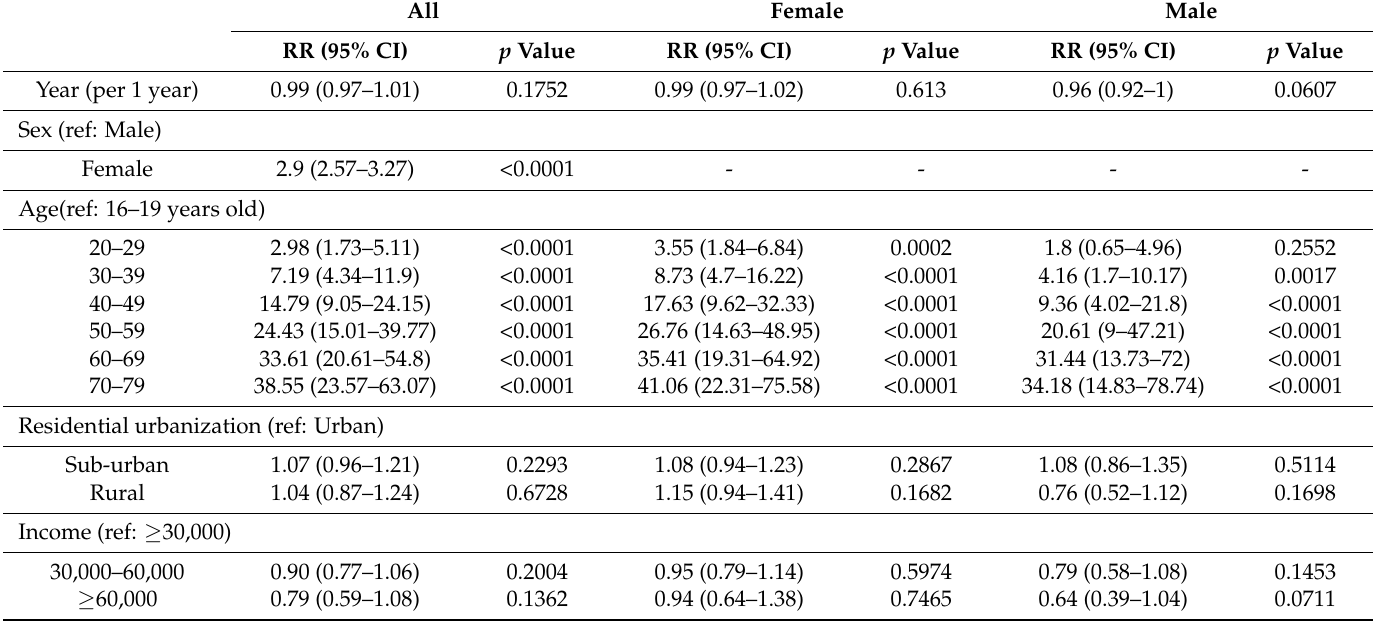
* Models was adjusted for calendar year, sex, age groups, urbanization and income